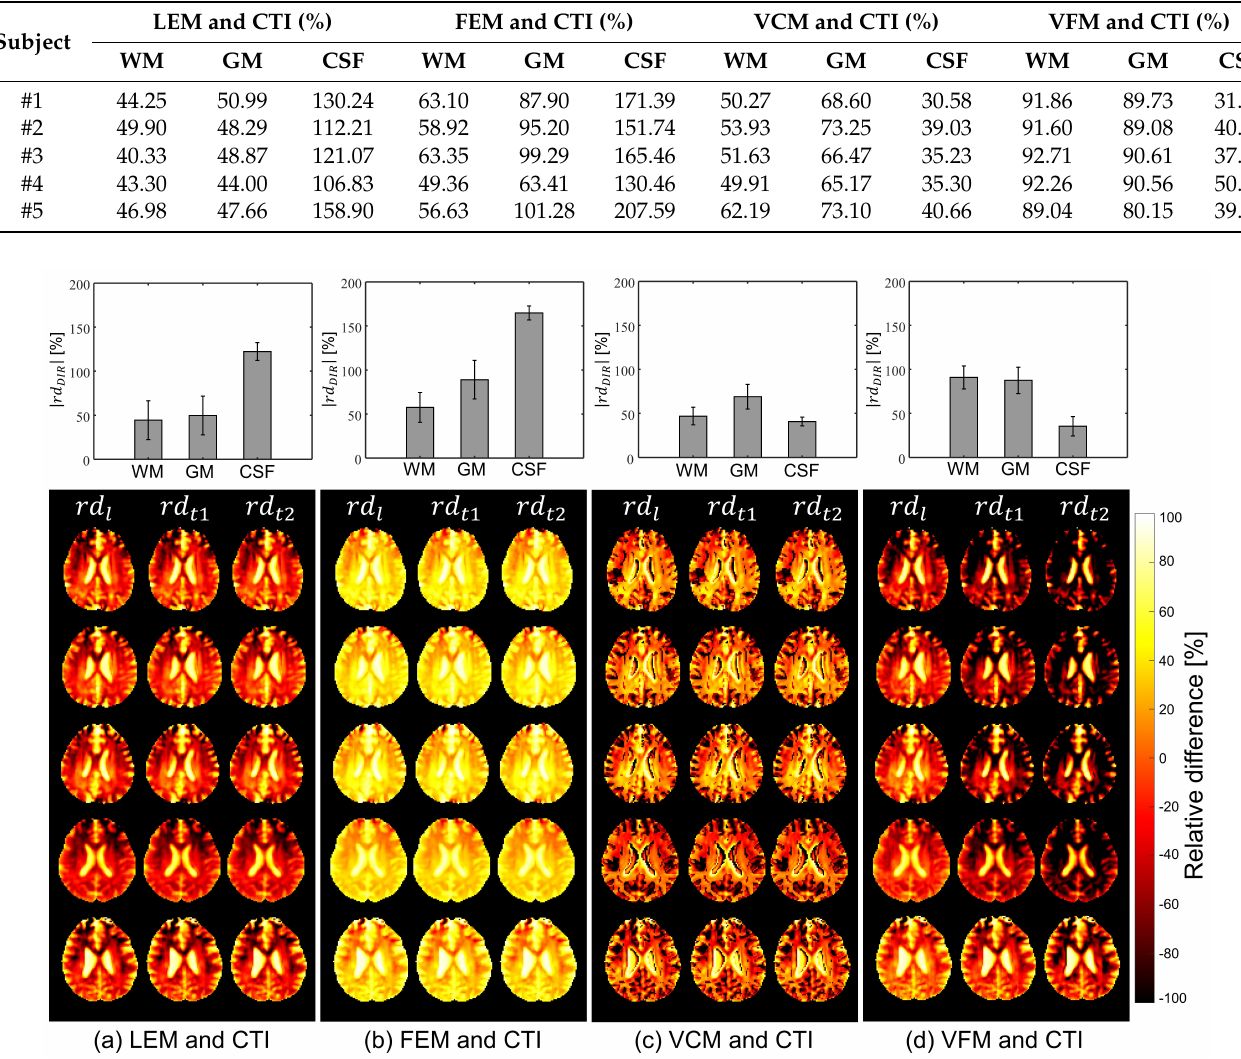
| ) in the WM, GM, and CSF regions for all five human subjects. Table 4. Mean values of the absolute relative differences ( | rd DIR The relative differences of the LEM, FEM, VCM, and VFM methods were computed with respect to the CTI method.